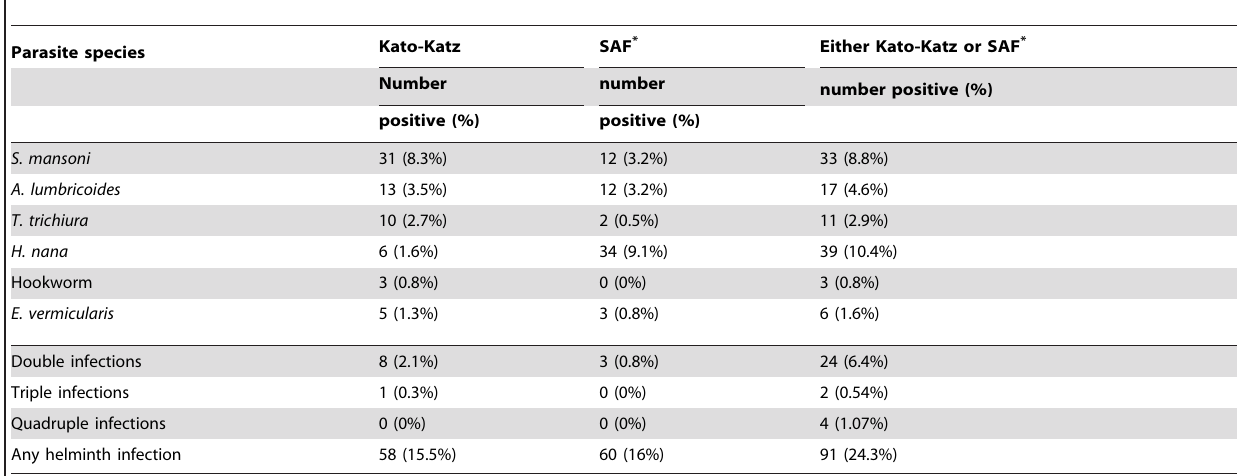
Table 2. Prevalence of intestinal helminthes infections as determined by Kato-Katz and SAF * methods among under five years of age in Wonji Sugar Estate, Ethiopia,